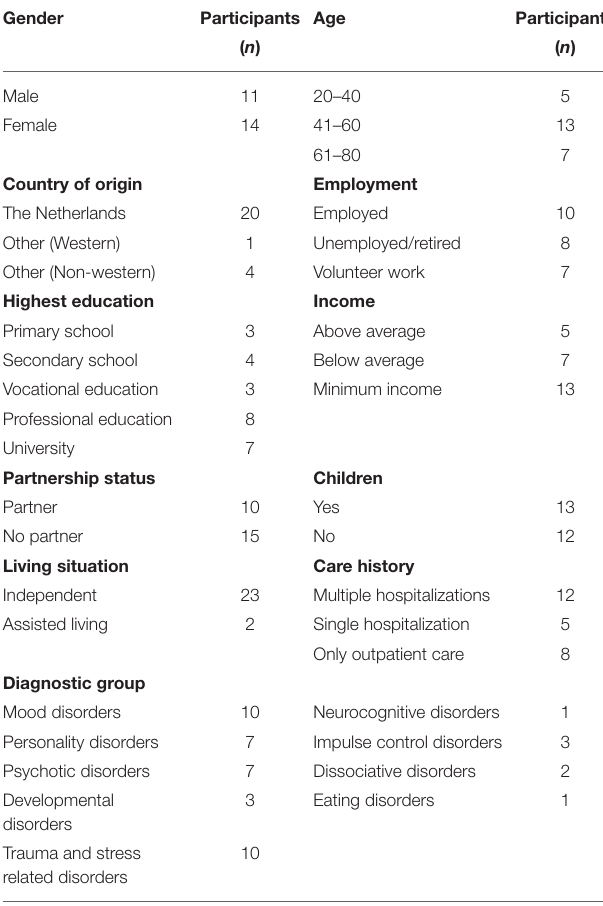
TABLE 1 | Characteristics of the participants ( n =